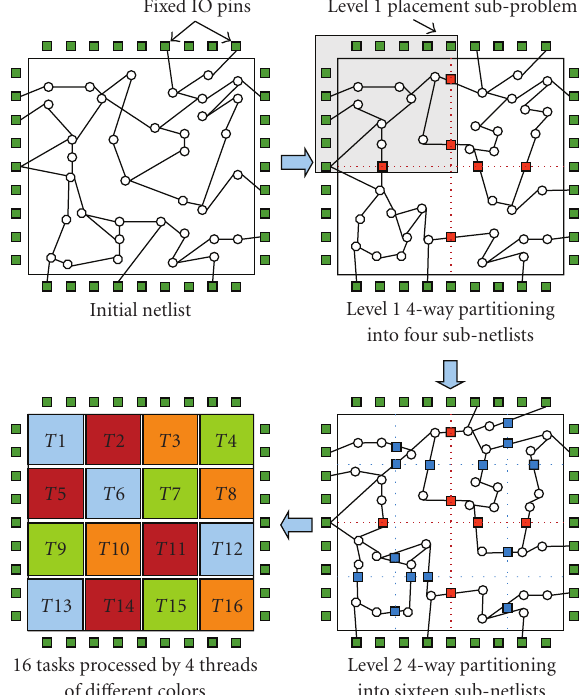
Figure 3: Illustration of Step 1. The FPGA is decomposed into multiple balanced regions using multilevel 4-way partitioning. These regions represent tasks to be processed